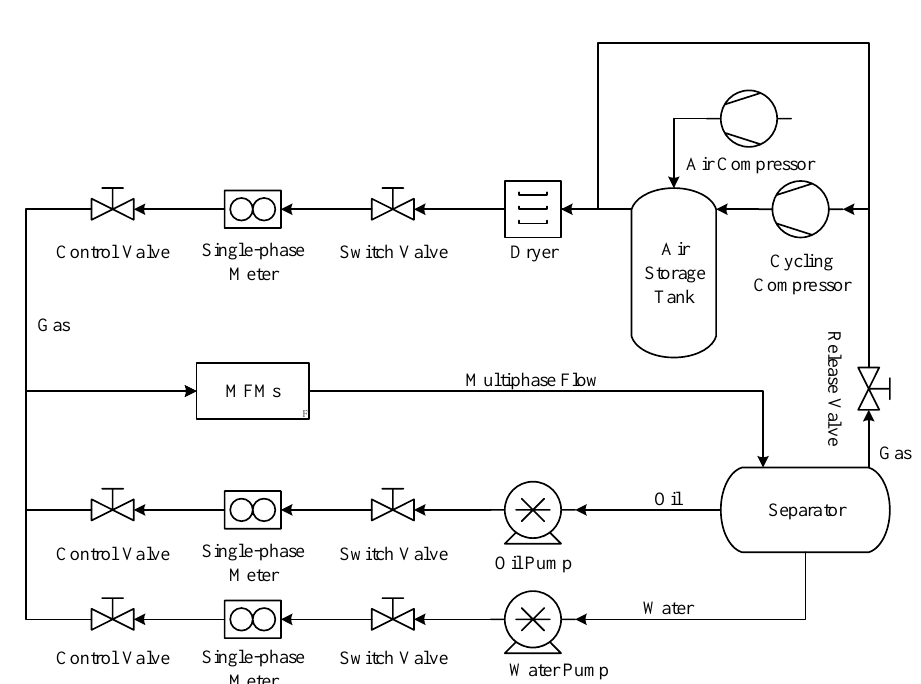
Figure 1. Schematic diagram of the multiphase flow experimental facility. The 20 test points are shown as red dots in Figure 2b, from which it is notable that the flow patterns are mainly slug flow and elongated bubble flow. The test pressure is 0.3 MPa, and the liquid and gas flowrate ranges are 2~5 m 3 /h and 15~75 Nm 3 /h respec- tively.